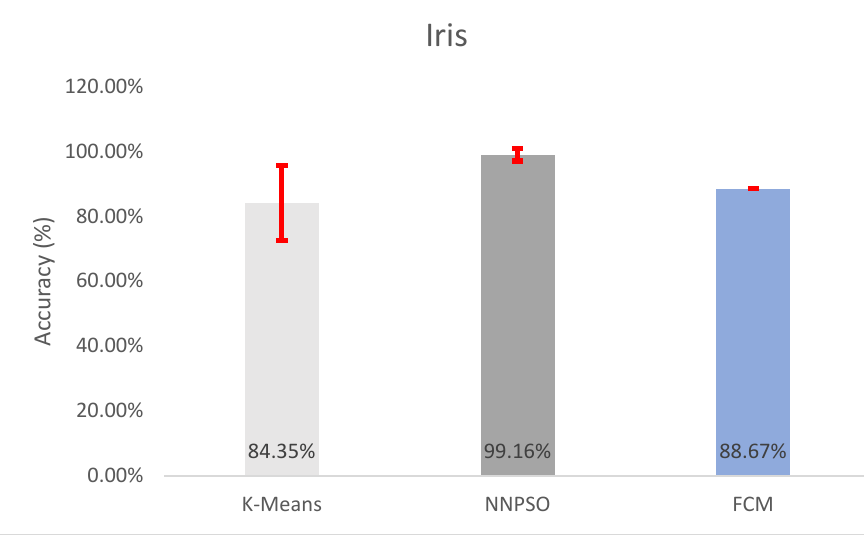
Figure 20. Accuracy of the algorithms on the Iris data set.